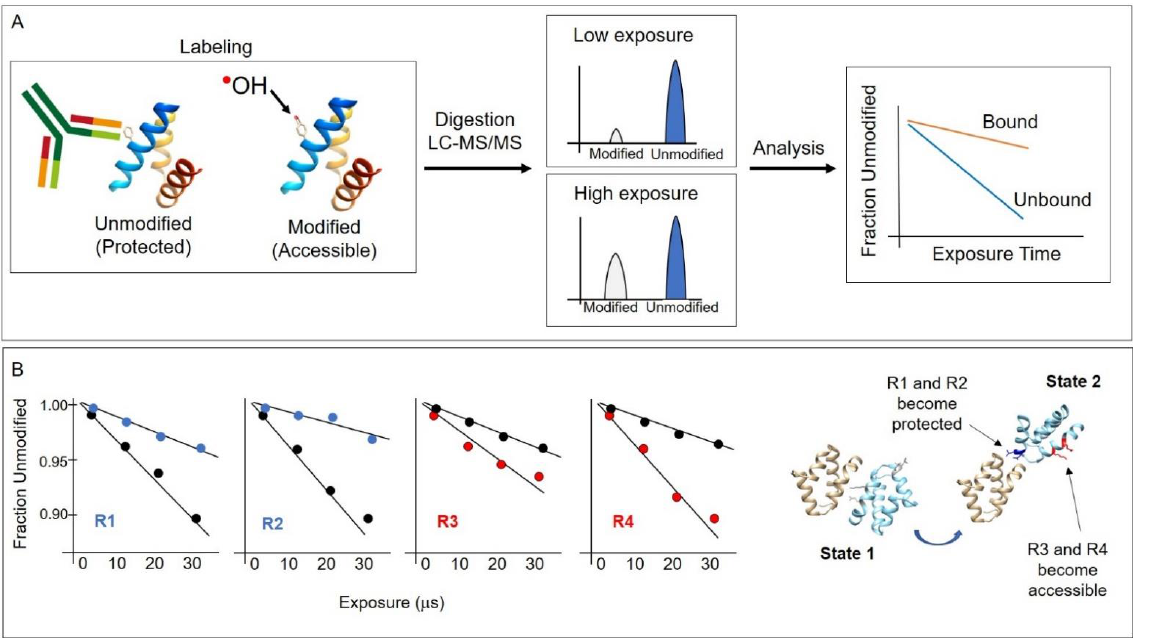
Figure 2. ( A ) Conceptual overview of the HRPF method. Hydroxyl radicals are generated through various means described in this article and covalently modify protein side chains that are not solvent protected, such as in an antibody – antigen interaction region. After hydroxyl radical labeling, pro- teins are digested, and LCMS is performed to identify sites of modification. Plotting the modifica- tion as a function of radical exposure reveals protected regions. Typically, the “fraction unmodified” is plotted per peptide or residue. ( B ) A hypothetical example to illustrate the application of the method. In this example, residues R1 and R2 become solvent protected, while residues R3 and R4 become solvent accessible when the protein conformation changes from one state to another, such as in the rotation of one domain relatively to another. The dose – response plots show the rate of modification differences between state 1 (black circles) and state 2 (blue or red circles) showing a decrease or increase in solvent accessibility, respectively.